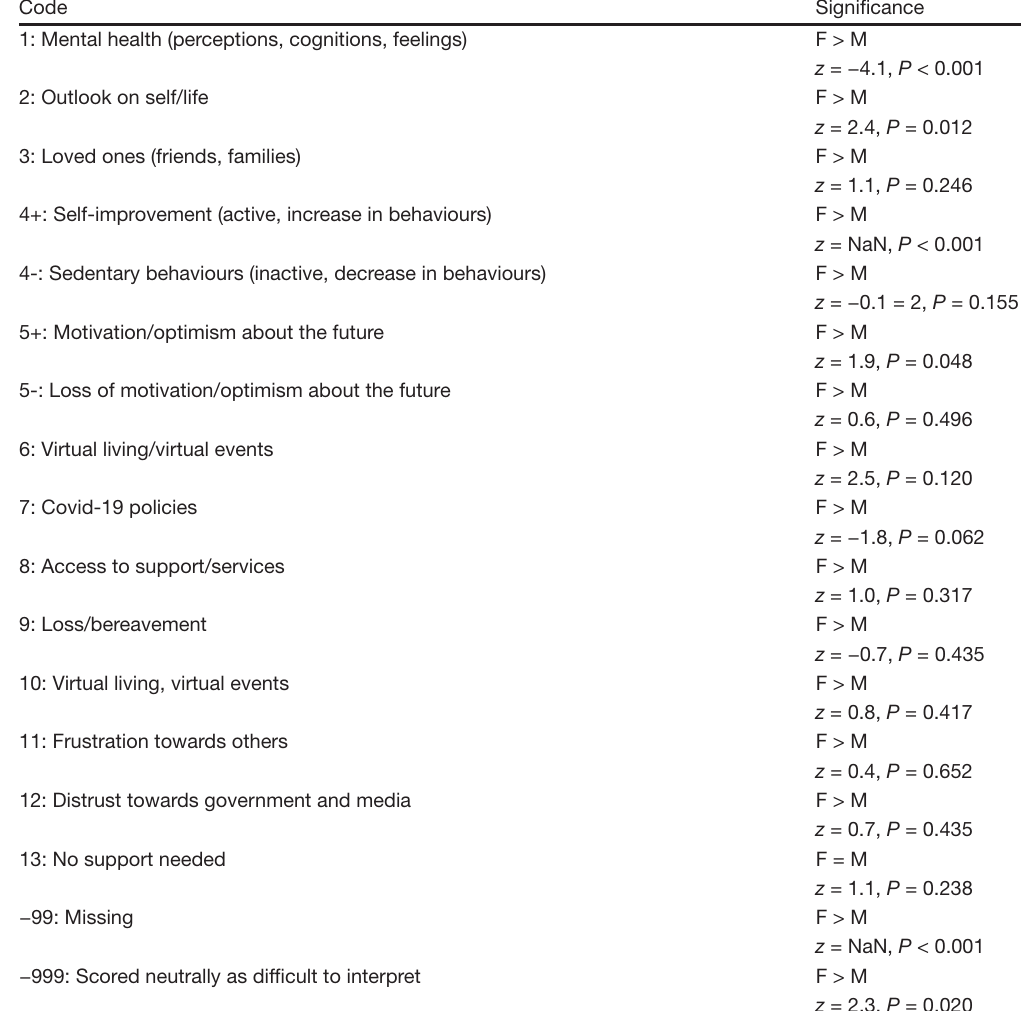
Table 6. Analysis of code frequencies by gender